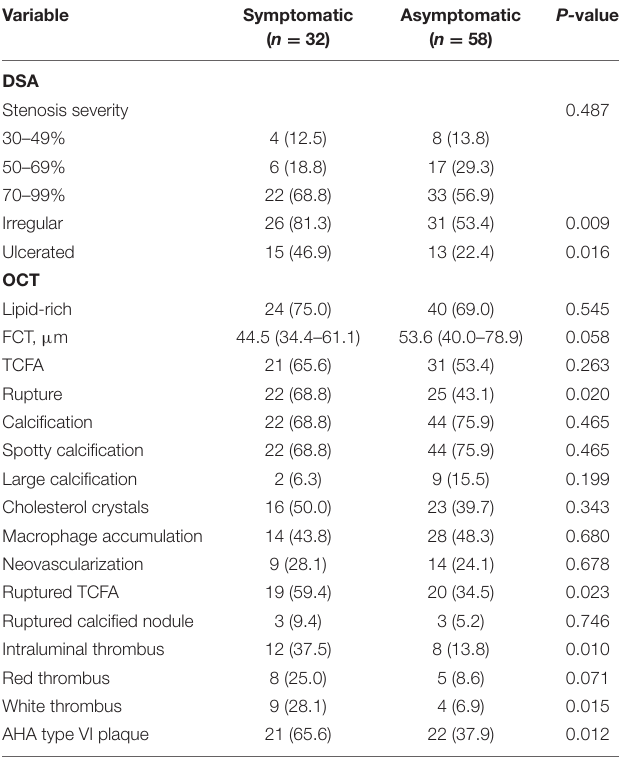
TABLE 2 | Plaque characteristics in symptomatic and asymptomatic group. TABLE 3 | Clinical and imaging indicators to identify symptomatic carotid plaque in the final multivariable regression